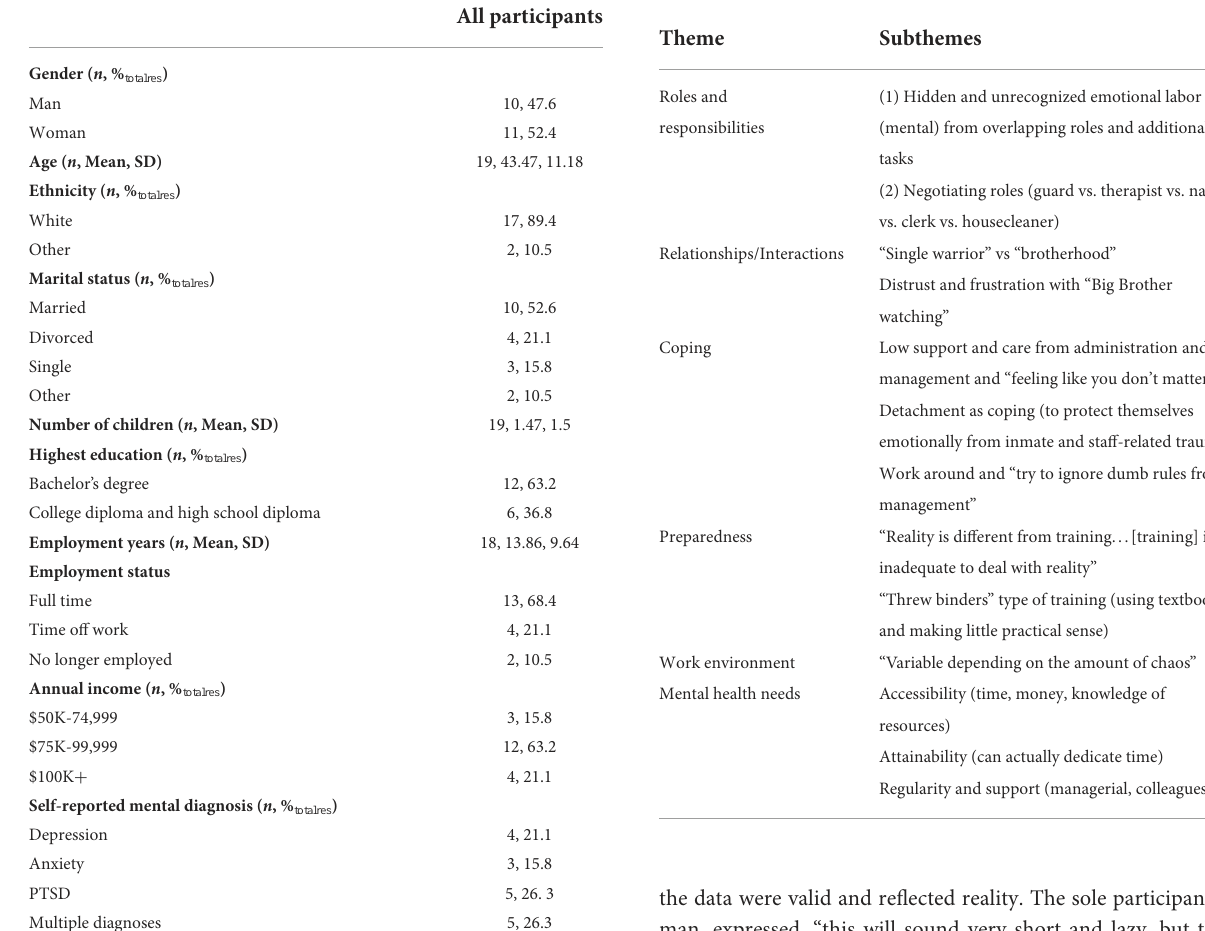
TABLE 1 Summary of participant demographics. TABLE 2 Summary of initial interviews and mixed-gender focus group